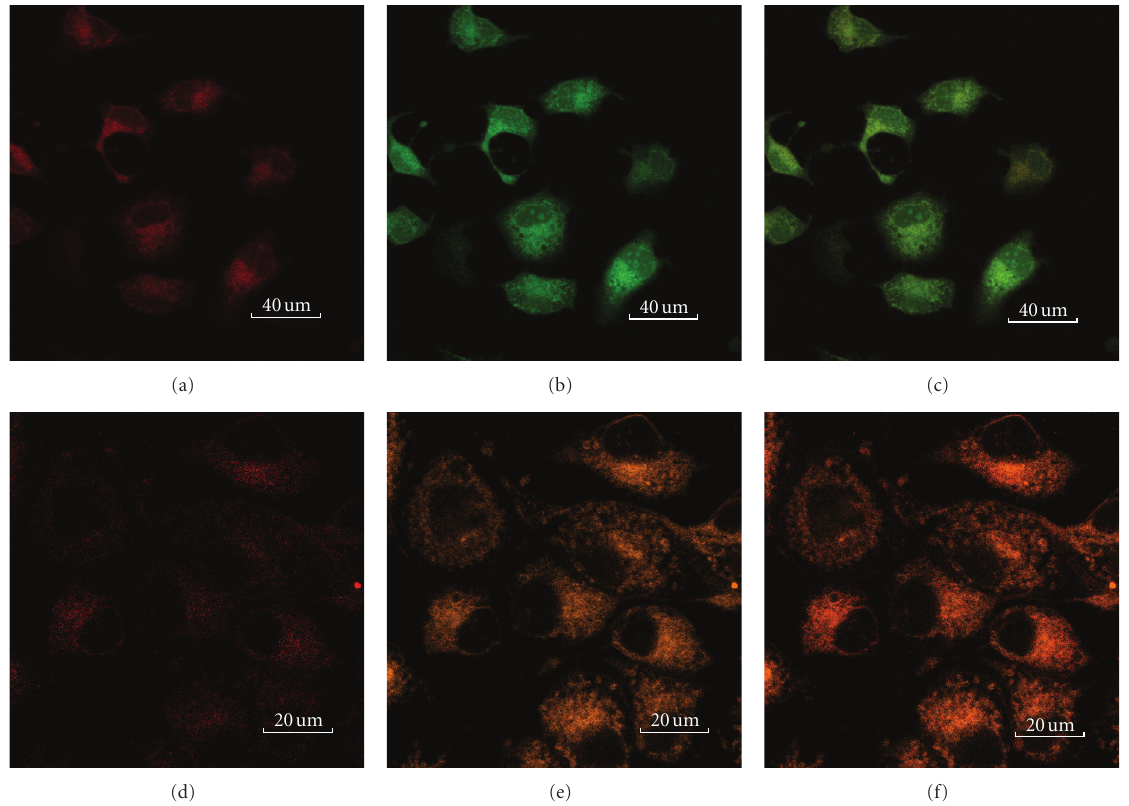
Figure 2: LSCM images of CPD4 in MCF-7 cells. (a) CPD4, (b) CPD4 and Rhodamine 123, (c) overlaid image of (a) and (b), (d) CPD4, (e) CPD4 and DiI-7, (f) overlaid image of (d) and (e).